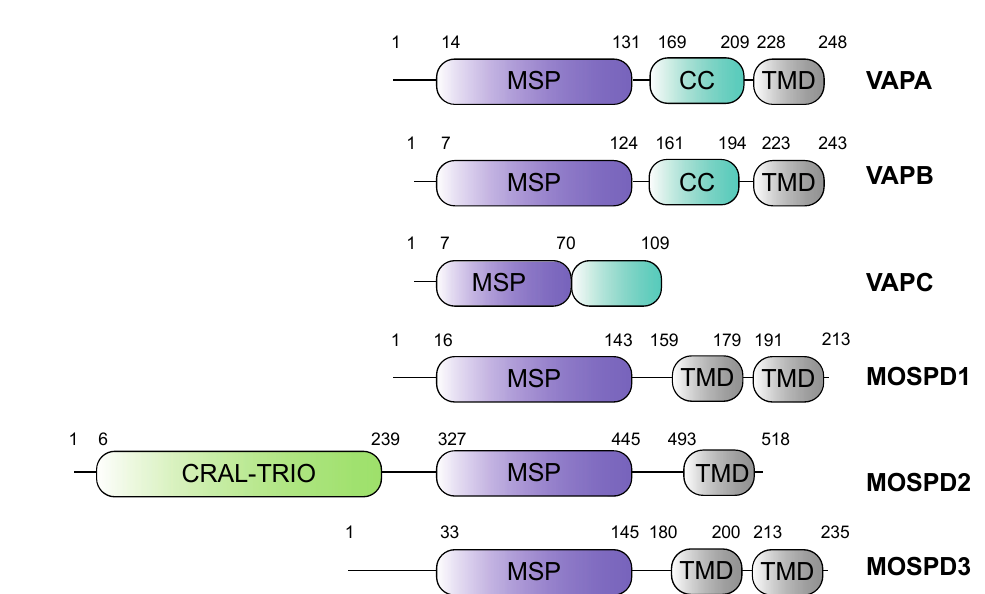
Figure 1. Domain structures of the VAP family of proteins. All VAP family of proteins have an MSP (Major Sperm Protein) domain. Both VAPA and VAPB contain a central coiled-coil domain (CC) and a C-terminal transmembrane domain (TMD). VAPC lacks the CC domain and the TMD. In addition to the MSP domain, MOSPD1 and MOSPD3 contain two TMDs at the C-terminal end, whereas MOSPD2 possesses a CRAL/TRIO (cellular retinaldehyde-binding protein and triple functional domain protein) domain at the N-terminal and a TMD at the C-terminal end.